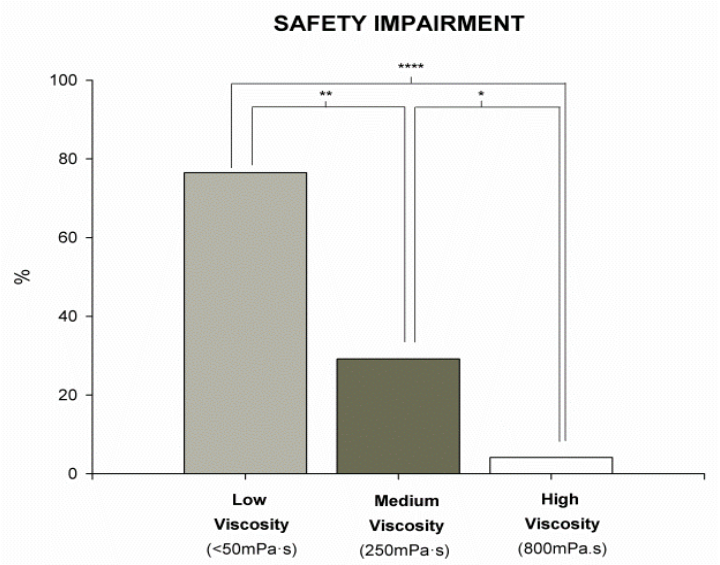
Figure 1. Prevalence of patients with impaired safety of swallow in the different tested viscosities (low, medium, and high) according to Volume Viscosity Swallowing Test (V-VST). * p < 0.05, ** p < 0.01, **** p < 0.0001.